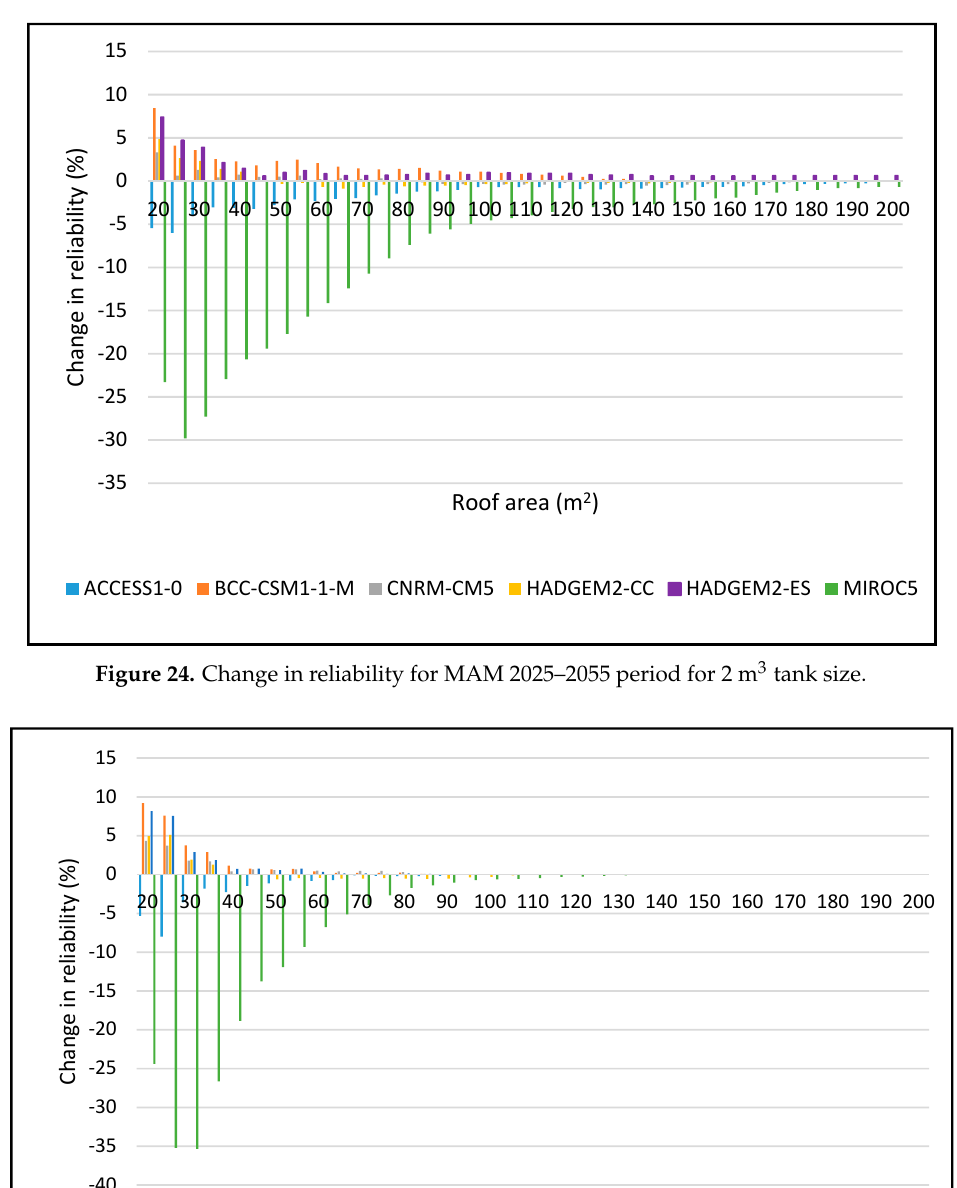
Figure 23. Reliability projections for JJA season for 5 m 3 tank size for 2060–2090 period.